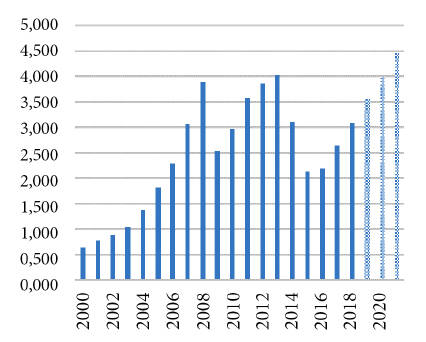
Figure 3. Economic growth tempo of Ukraine, 2000–2021, % (source: authors’ researches)